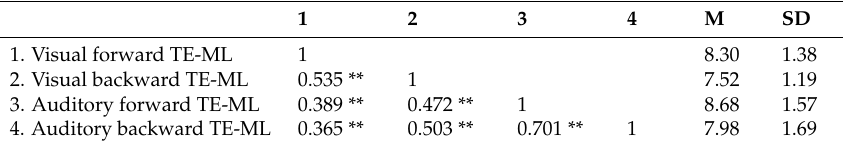
Table 7. Correlations between selected WM variables.